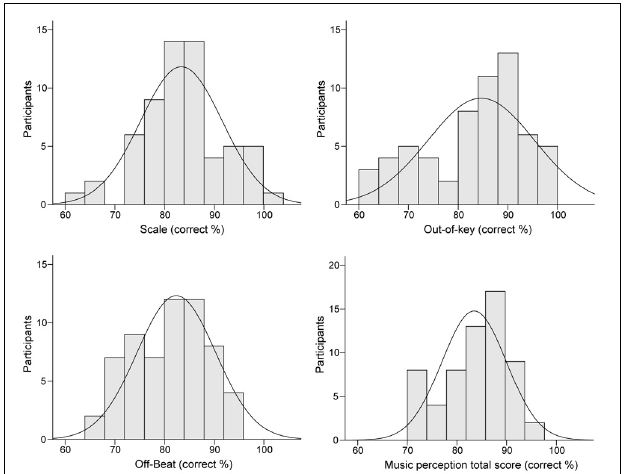
FIGURE 4 | Distributions of the music perception subtest and total